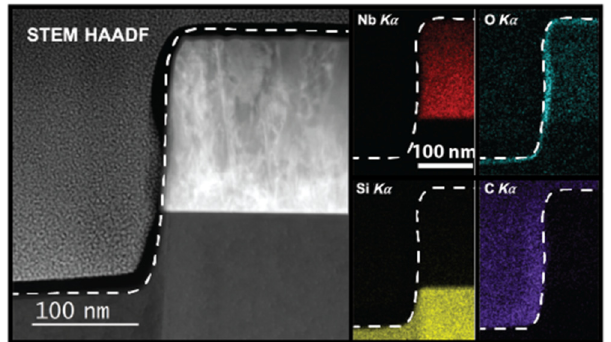
FIG. 2. A STEM cross-section image of a standard (nonetched) Nb-Si resonator. The high-angle annular dark- field image on the left maps large-angle electron-scattering intensity, which increases with the atomic number Z . The bright area is the Nb film and the contrast variation reflects dislocations and grain boundaries in the sputtered film. The black border and the speckled region on the left are, respectively, the carbon and platinum layers deposited during sample preparation. The uniform gray area below is the Si(100) substrate. The dashed white lines separate the resonator surface from the deposited layers. The “blurring” of the Nb sidewall is due to the projection of the surface roughness through the approximately 50-nm-thick cross-section lamella. The thin gray layers next to the protec- tive carbon are the Nb and Si surface oxides. The elemental energy-dispersive spectroscopy (EDS) maps on the right show the Nb, O, Si, and C distributions. The thicker Nb and thinner Si surface oxides are clearly visible in the O map. (During sample preparation, monolayer amounts of oxygen and carbon can absorb on the freshly exposed surfaces of the